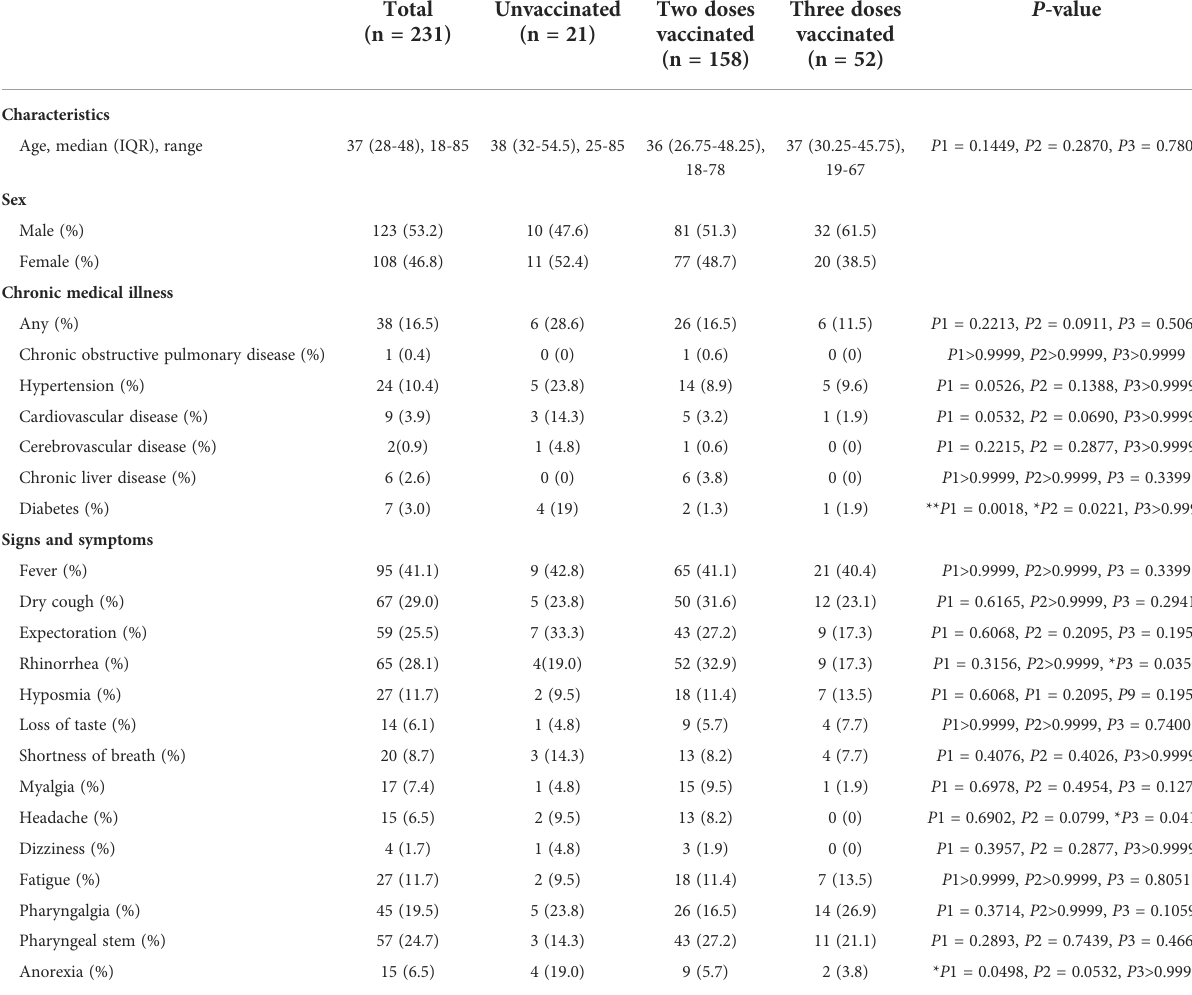
TABLE 1 Demographic and baseline characteristics of patients with